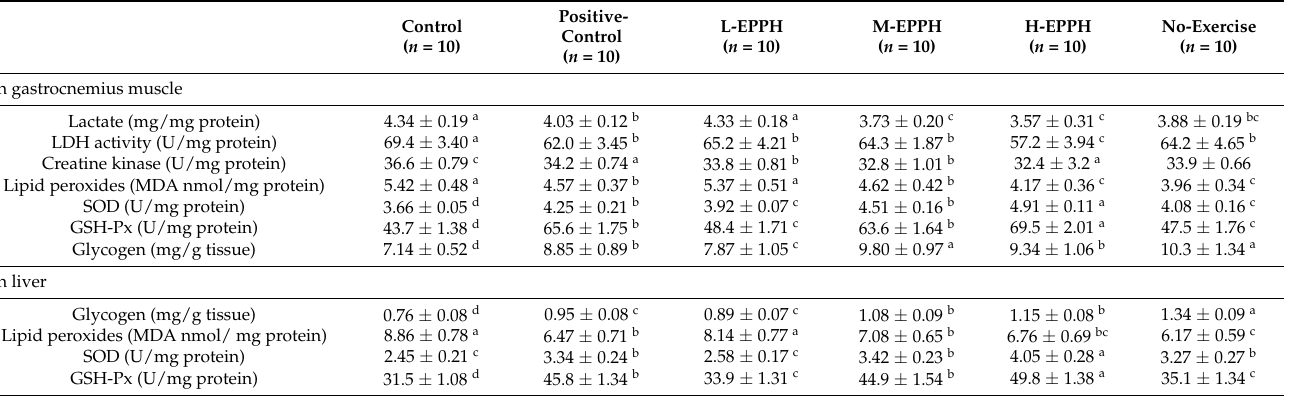
Table 4. Metabolic parameters related to exercise-induced fatigue in the liver and muscle at 30 min of intense exercise after the 6-week